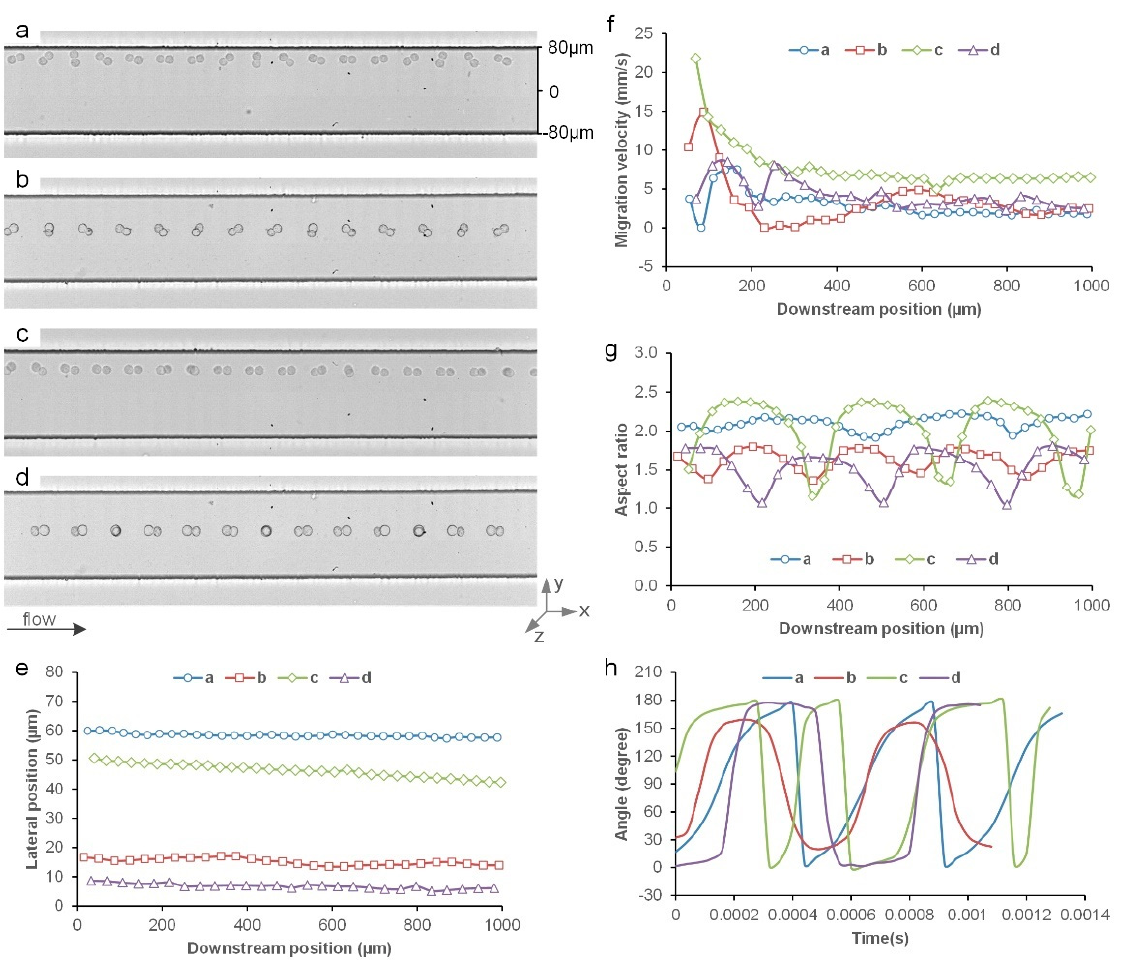
Figure 2. Inertial migration of doublets: ( a ) A cell doublet near channel sidewall slowly migrates away from the wall while rotating about the z-axis; ( b ) A cell doublet shows a kayaking motion as it moves downstream the channel; ( c ) A cell doublet is transitioning to tumbling motion (rotating about y-axis); ( d ) A cell close to the channel centerline is tumbling downstream; ( e – h ) The lateral displacement, lateral migration velocity, aspect ratio, and the orientation of the four doublets in ( a – d ). The bright-field images in ( a – d ) are stacked every two frames to show the trajectories of the cells.